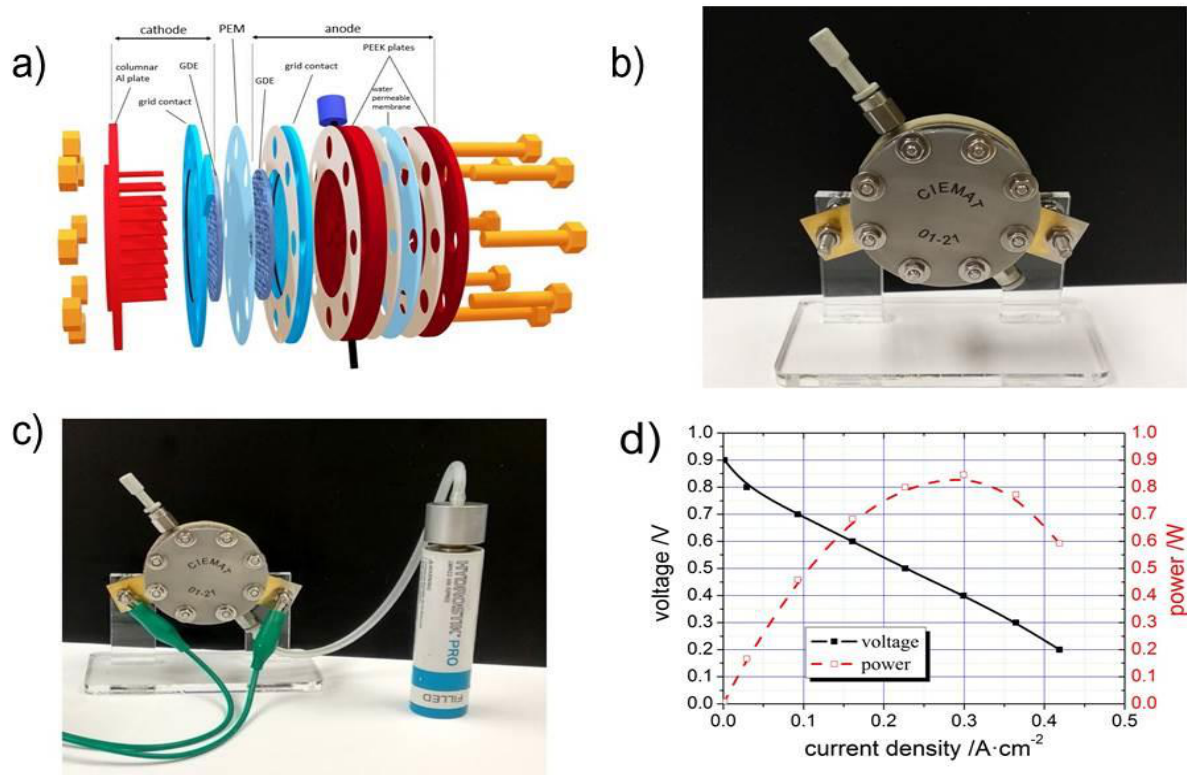
Figure 1. ( a ) Exploded view of the portable PEMFC; ( b ) front view of the cell (5 cm diameter); ( c ) view of the cell and hydrogen cartridge for portable applications; ( d ) stabilized polarization curve and power delivered.